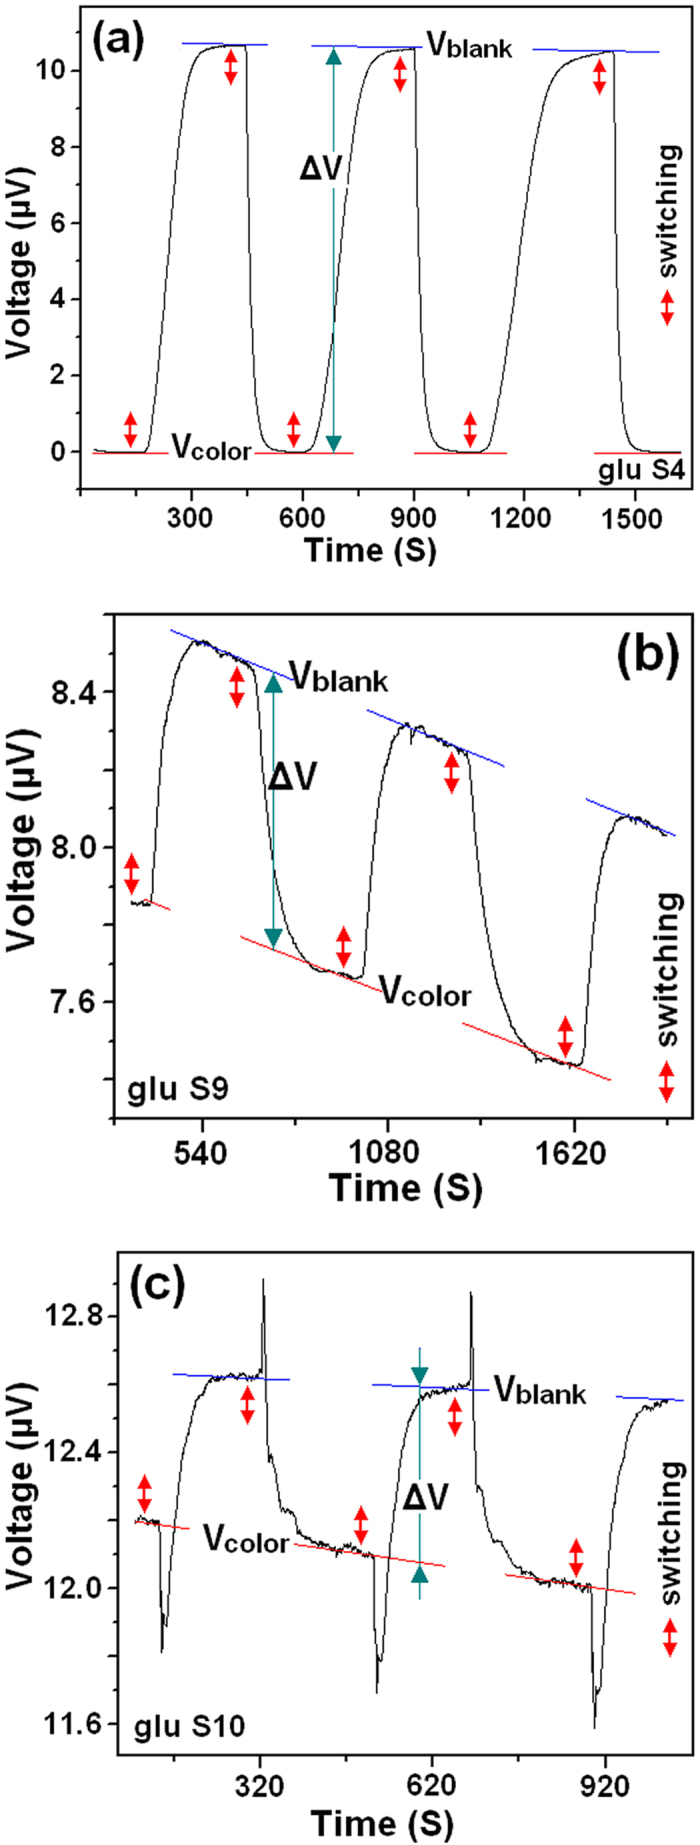
Measurement results of (a) sample 4, (b) sample 9 and (c) sample 10 by using the MWC-based photometer.